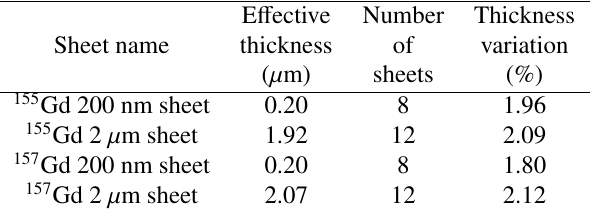
Table 2. Characteristics of the sample sheets.